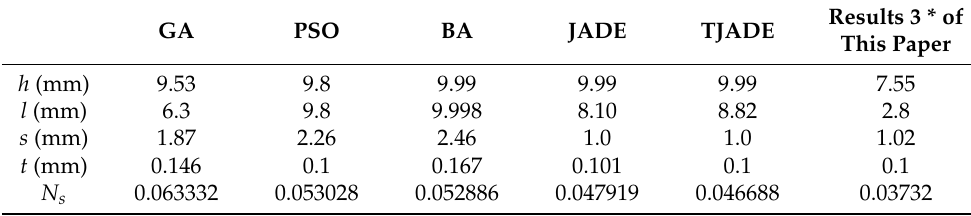
Table 4. Comparison of optimization results with other